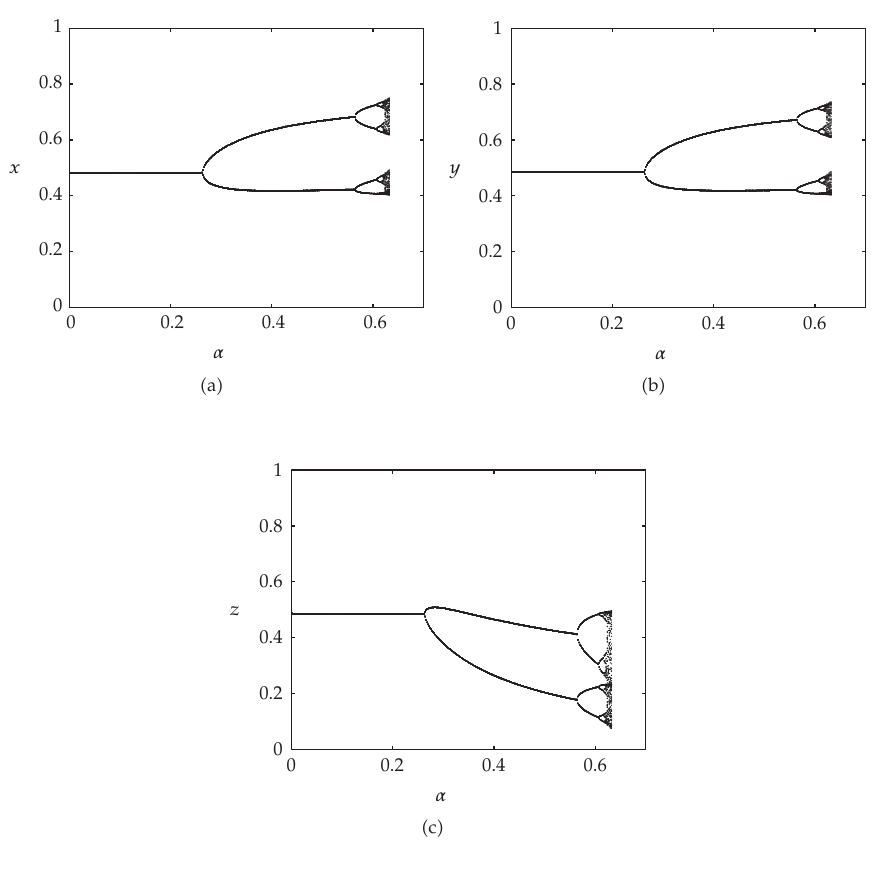
Figure 2: The state of the outputs with r (cid:7) 0 . 4, α (cid:7) 0 − 0 . 63.